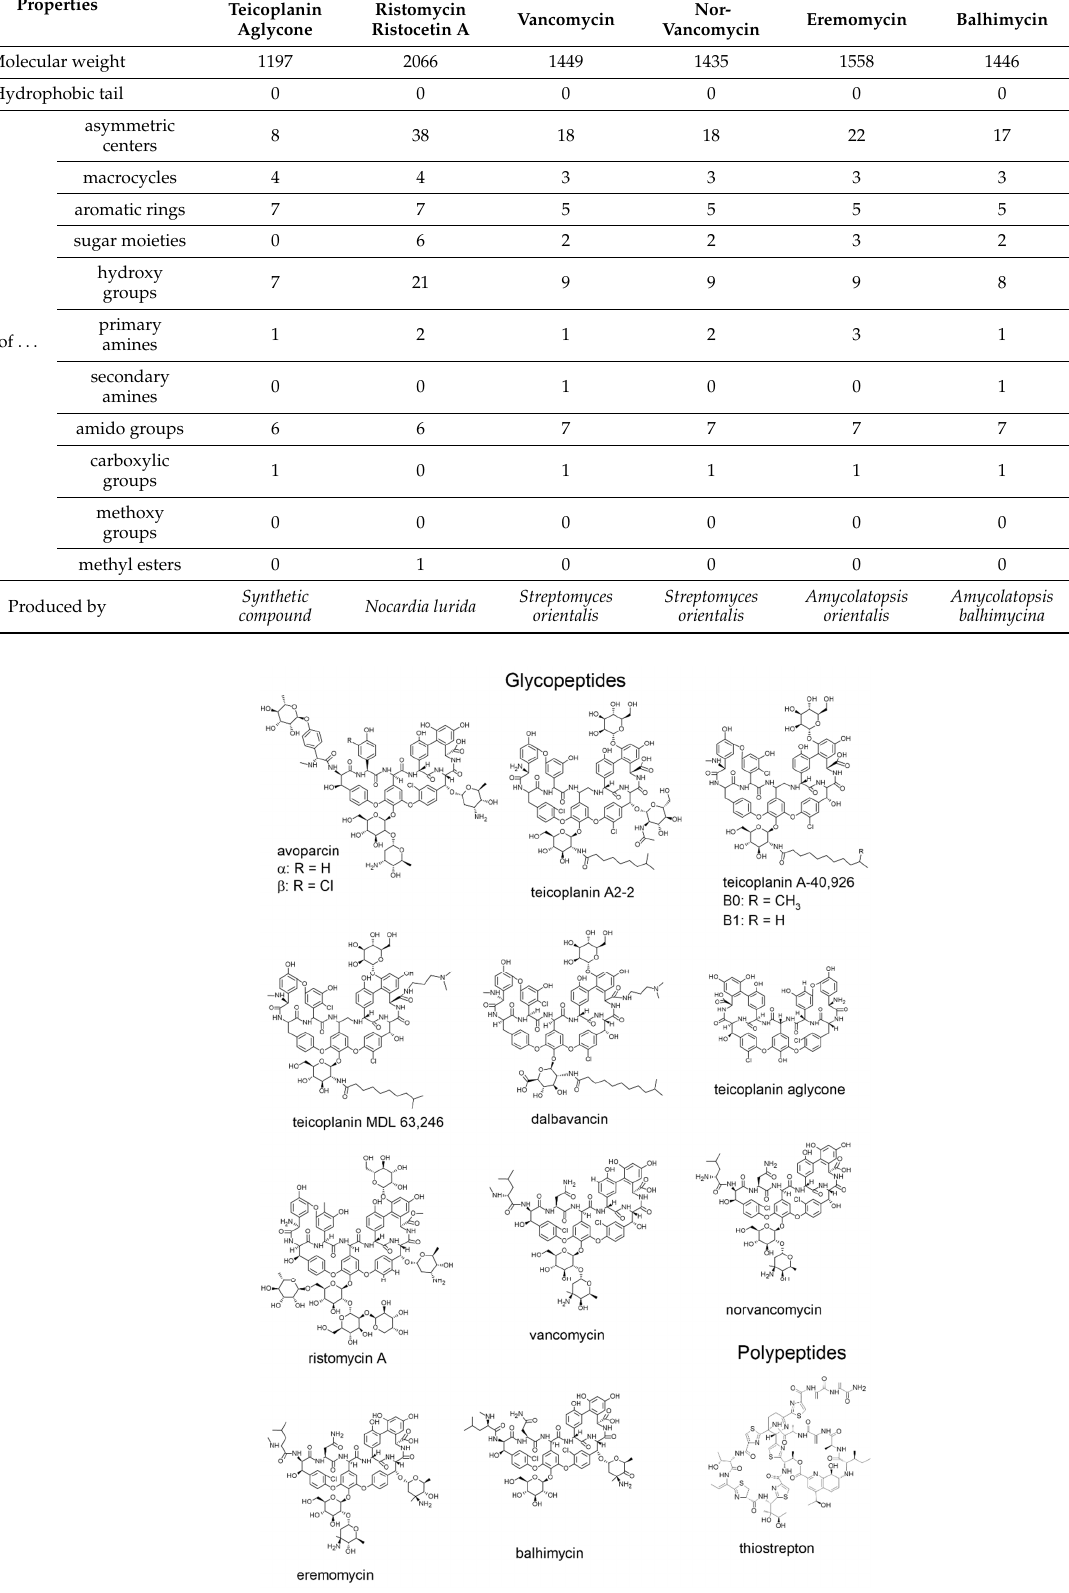
Figure 2. Structure of glycopeptides and